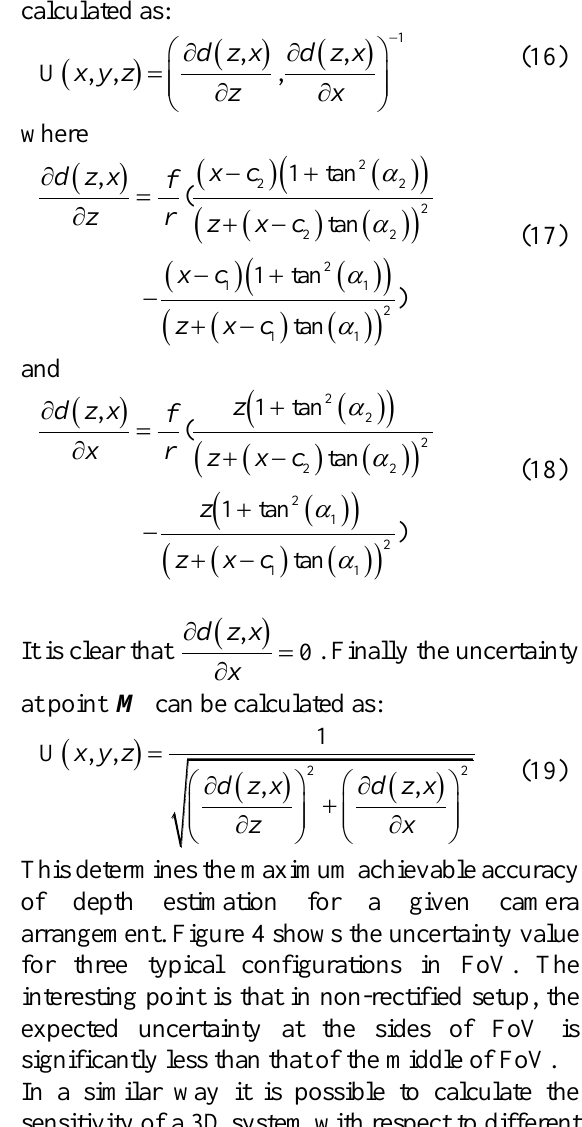
correspondence matching algorithm, the error stems from the matching process. On the other  T hand is related to the camera configuration on d  the scene and its